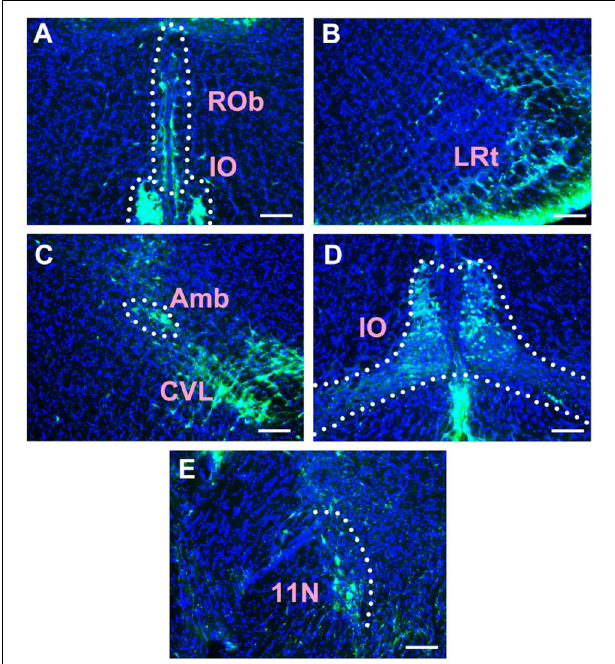
FIGURE 9 | The distribution of neurons labeled by CB in the medulla oblongata Part IV (A–E) . Rob, raphe obscurus nucleus; IO, inferior olive; LRt, lateral reticular nucleus; Amb, ambiguus nucleus; CVL, caudoventrolateral reticular nucleus; 11N, accessory nerve nucleus. Scale bar = 100 µ m.